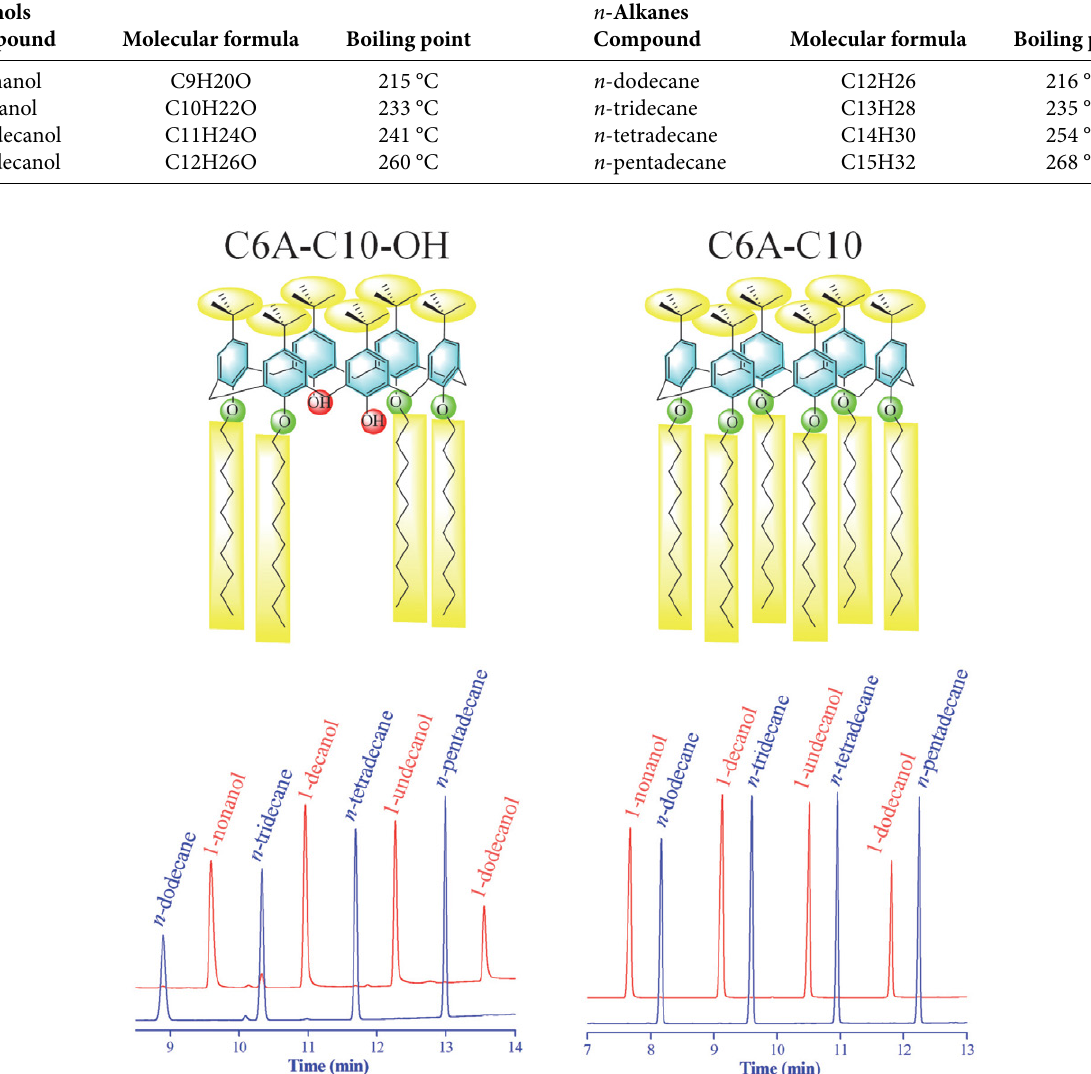
Fig. 5. GC separations of the alcohols and n -alkanes on the C6A-C10-OH and C6A-C10 columns. Temperature process: 40 °C (keep 1 min) up to 160 °C (keep 5 min) at 10 °C/min and gas flow rate at 0.6 Zhang et al.: Synthesis, Crystal Structure and Separation Performance ...